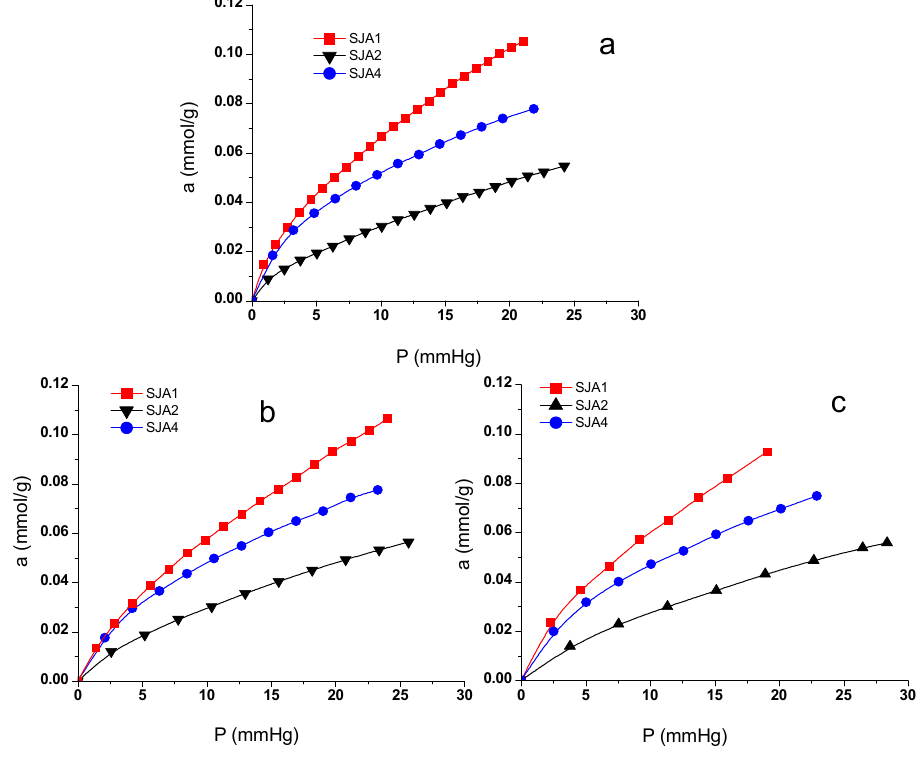
Figure 4. Adsorption isotherms of CO 2 at different temperatures ( a ) 473 K; ( b ) 523 K; and ( c ) 573 K.